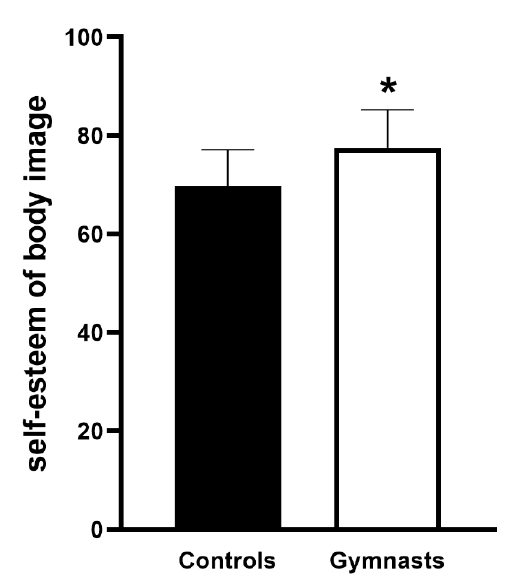
Figure 2. Body image perception of the gymnast group (which included the gymnasts of both the HPM and HCM groups) compared with the control group (the control group consisted of sedentary peers). A subscale of the multidimensional test of self-esteem was used to analyze self-esteem of body image. Error bars depict SEM. Asterisks (*) depict statistically significant differences. Statistical significance is set at p < 0.05; n = 28 in each group.